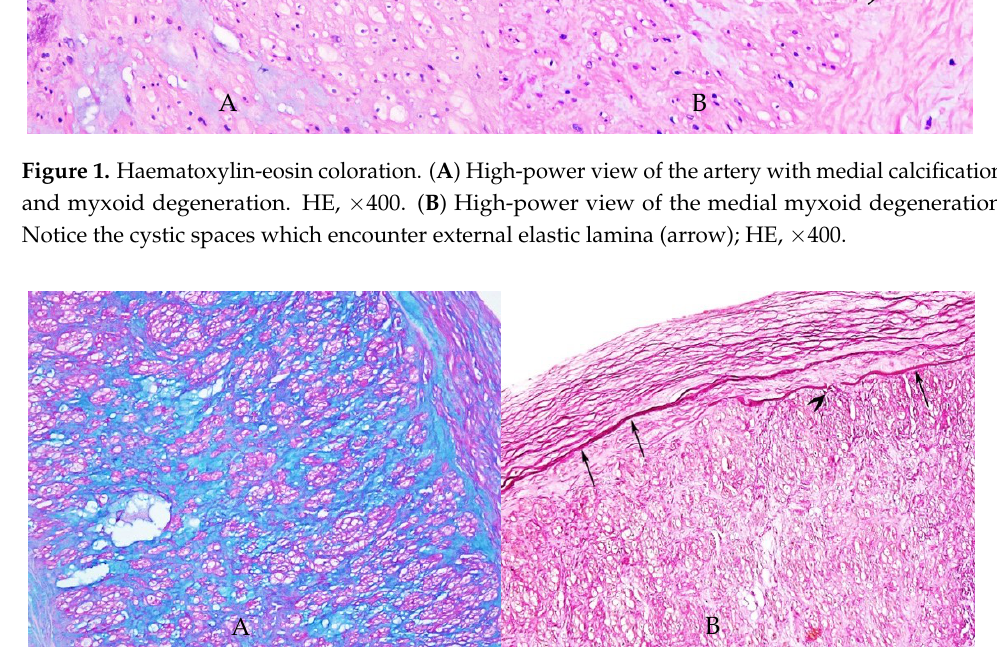
Figure 2. ( A ) AB-PAS stain highlights acid mucins (blue stain) within the entire wall of the artery; ×200. ( B ) Elastica van Gieson stain highlights the internal elastic lamina (arrows) which is focally interrupted (arrowhead), ×100.